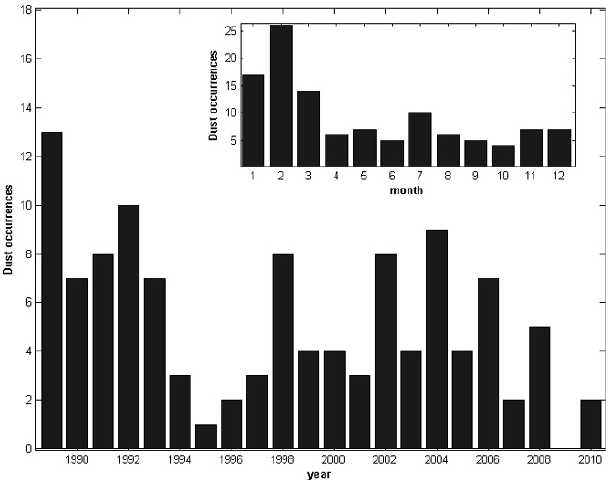
Fig. 6. Histogram of dust events duration over the Canaries for the period 1989–2010 from METARs and log–log representation with fitted straight line (inset figure).